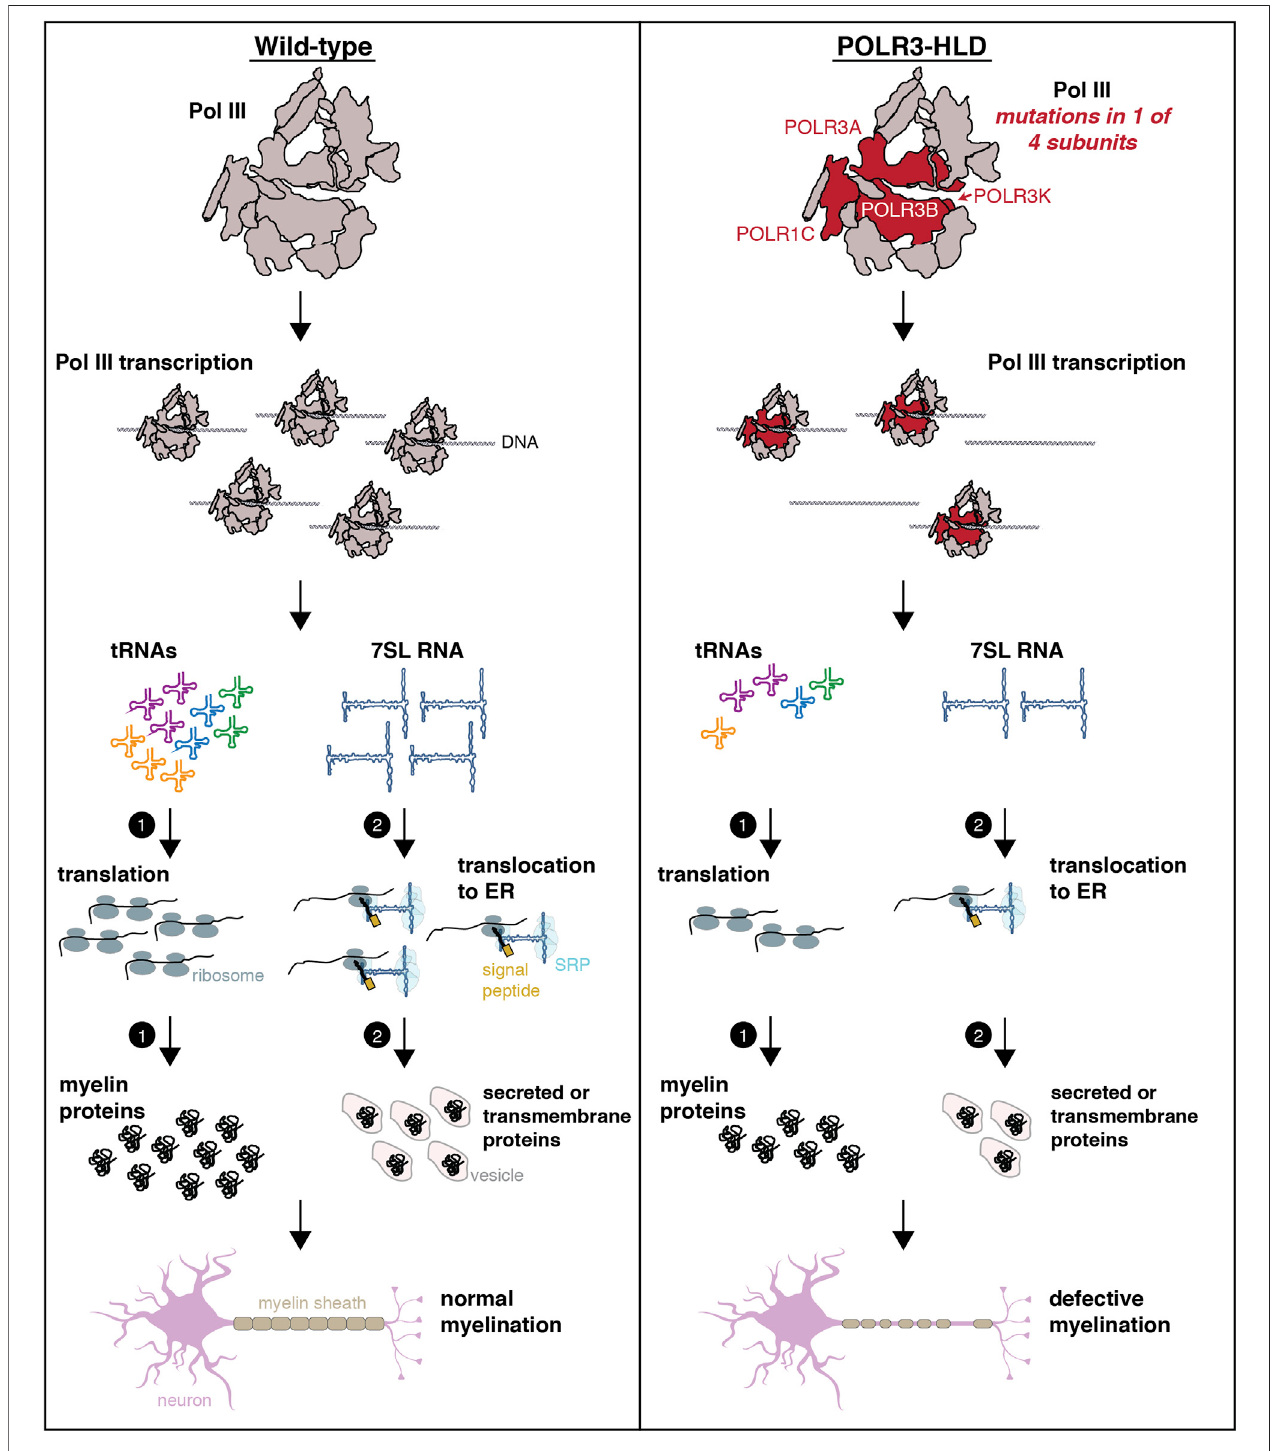
FIGURE 4 | Schematic representing possible mechanisms underlying POLR3-HLD. In wild-type conditions (healthy individuals), Pol III synthesizes small ncRNAs that play essential roles in housekeeping processes such as translation and co-translational targeting of nascent peptides, which are necessary for the production of myelin.InindividualswithPOLR3-HLD,itishypothesizedthatmutationsinPolIIIsubunits(POLR3A,POLR3B,POLR1CorPOLR3K)resultinreducedPolIIItranscription anddecreasedlevelsofPolIIItranscripts.The “ tRNA-centric ” hypothesispostulatesthatlowerlevelsoftRNAs(eitherglobally,forspeci fi canticodonsorforspeci fi c isodecoders) will impact translation and synthesis of proteins that are essential for myelination. Alternatively or in addition, reduced levels of other Pol III transcripts may contribute to POLR3-HLD pathogenesis through suboptimal performance of their respective functions that will particularly affect oligodendrocytes and/or neurons. An example is shown for 7SL RNA, where reduced levels of this ncRNA could impair translocation of secreted or transmembrane proteins to the ER, which could impact production of myelin. The schematic of the neuron was adapted from images available on https://smart.servier.com.